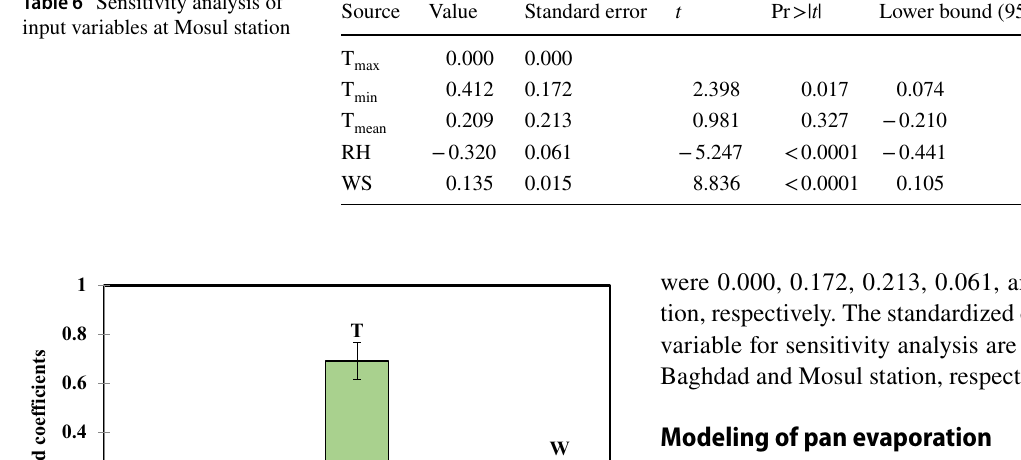
Table 6 Sensitivity analysis of input variables at Mosul station